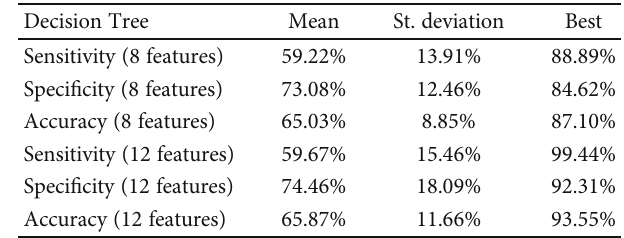
Table 13: Results of SVM with a sigmoid